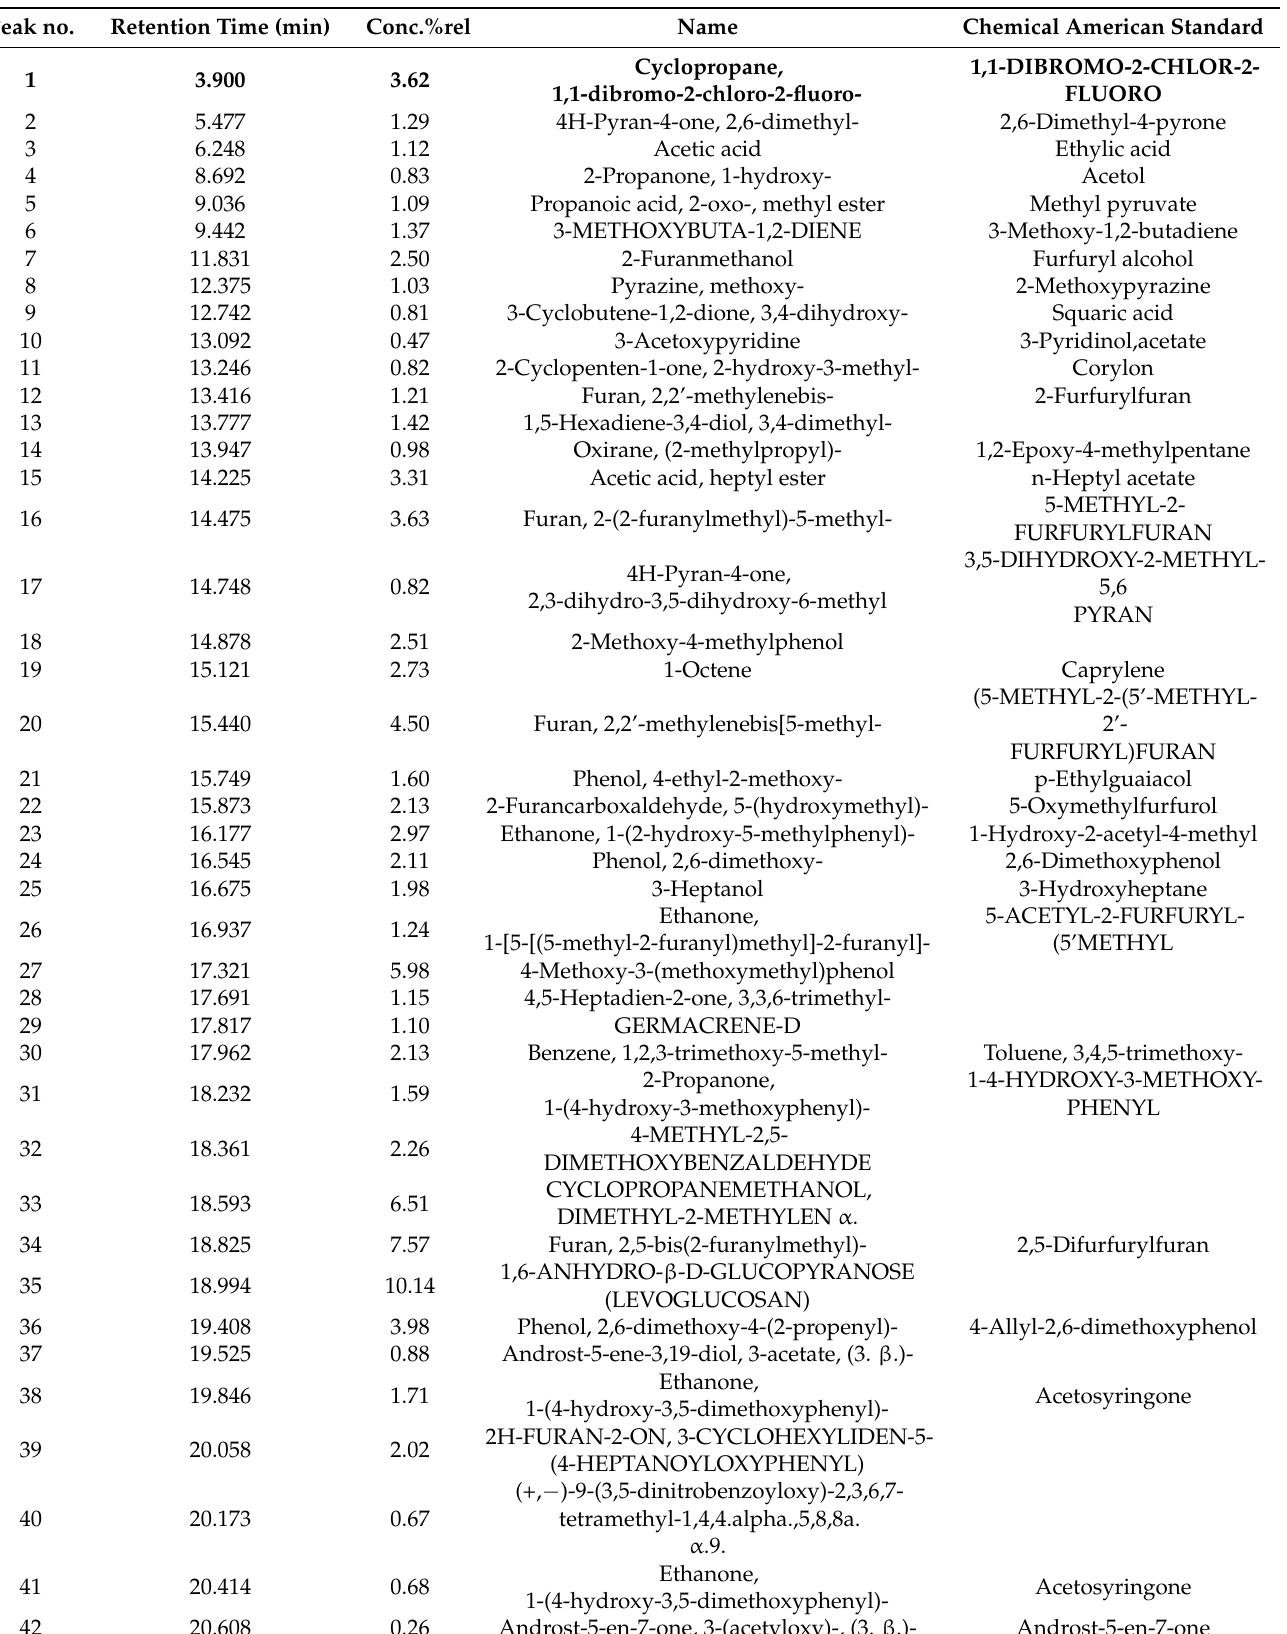
Table 8. Chemical compounds in furfurylated jabon after 1 year test based on Py-GCMS. Peak